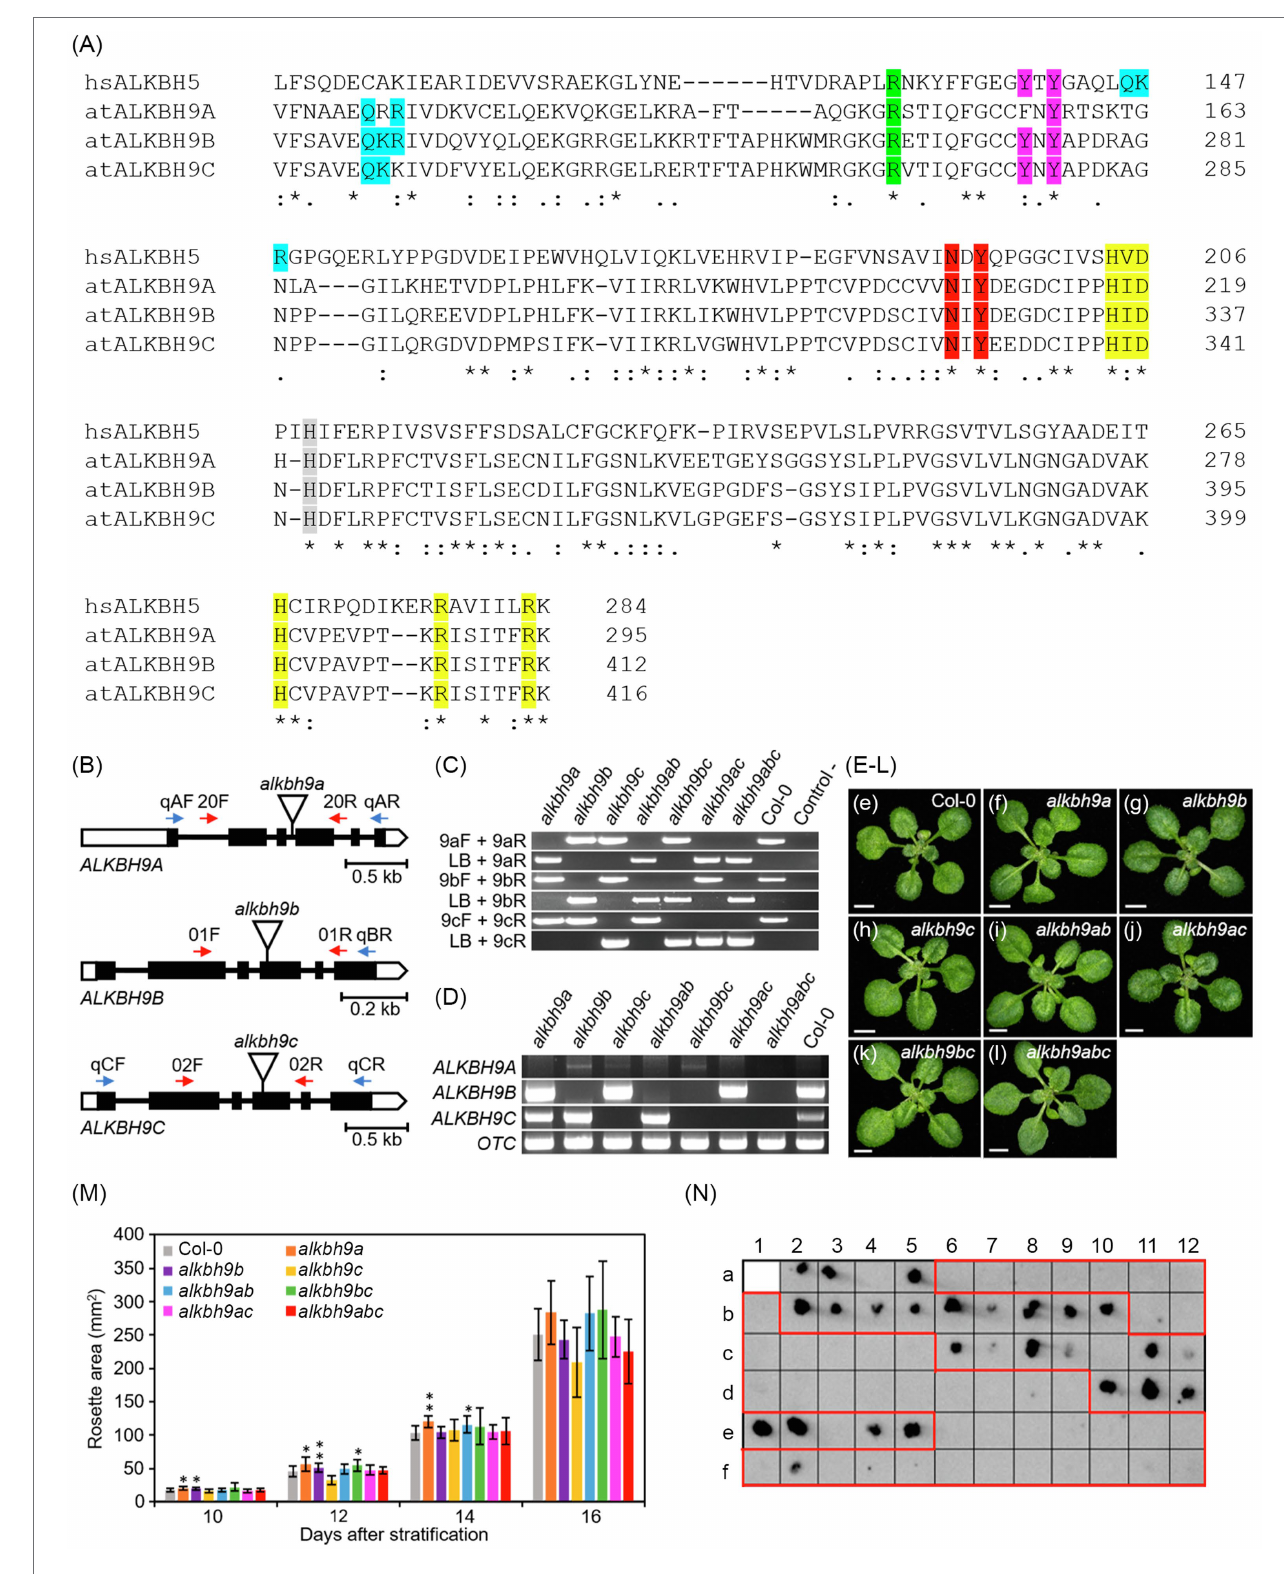
FIGURE 1 | ALKBH9A and ALKBH9C are not involved in AMV systemic infection. (A) Multiple alignment of the amino acid sequences of the AlkB domain from ALKBH9 Arabidopsis paralogs and human ALKBH5. Protein sequences were obtained from the Arabidopsis Information Resource